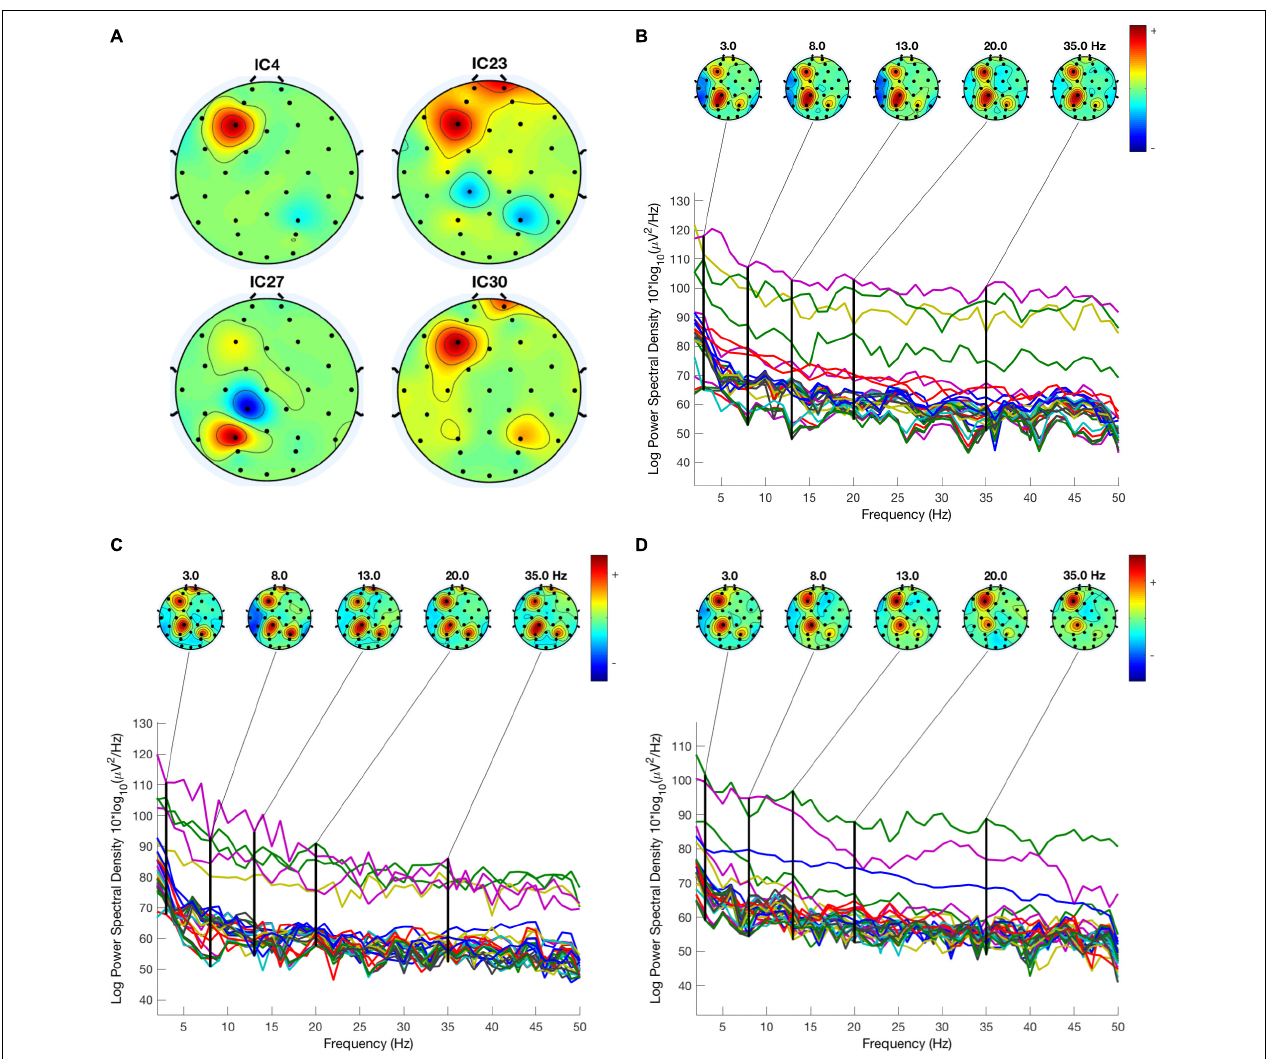
Figure 13 , the flowchart of our multi-modal with decision- level fusion. The Genetic algorithm (GA) (Mirjalili, 2019) was applied in the Multi-signals fusion part. The procedure of the fusion is as follows. The fused score can be defined using the